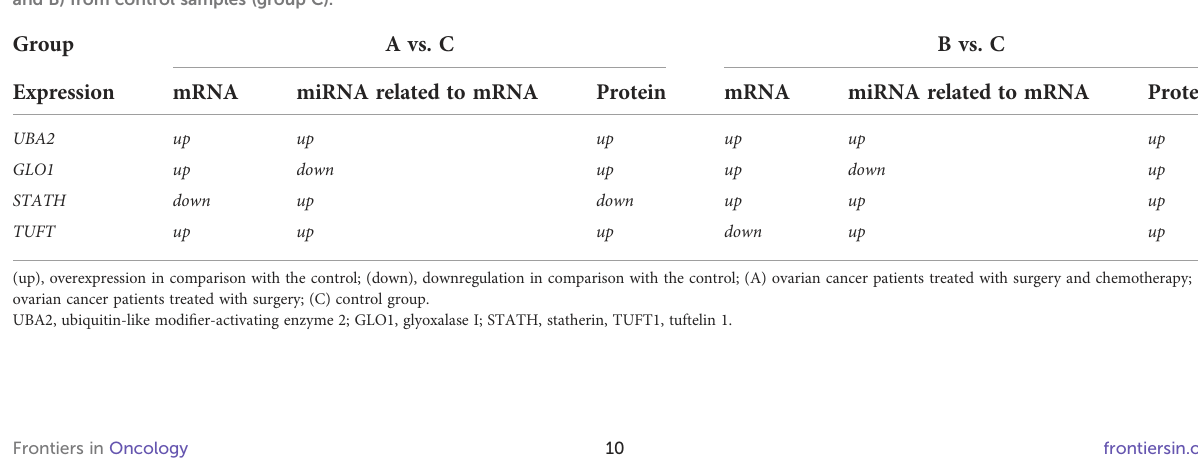
TABLE 6 Summarizing the changes in the expression of the selected mRNA-miRNA-protein for differentiating ovarian cancer samples (groups A and B) from control samples (group C). Group